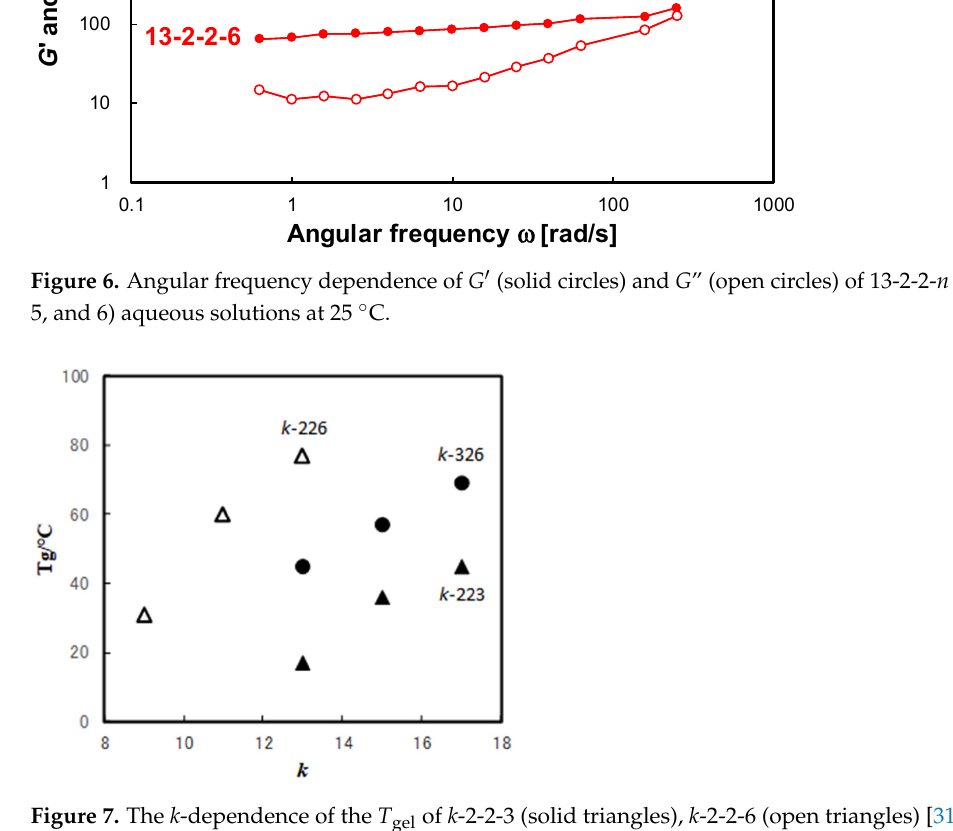
Figure 8. Angular frequency dependence of G ′ (solid circles) and G ″ (open circles) of the k -2-2-6 ( k = 9, 11, and 13) aqueous solutions at 25 °C.